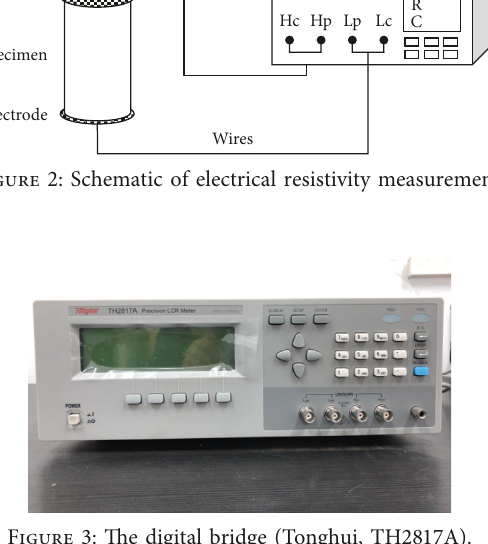
Figure 3: The digital bridge (Tonghui,